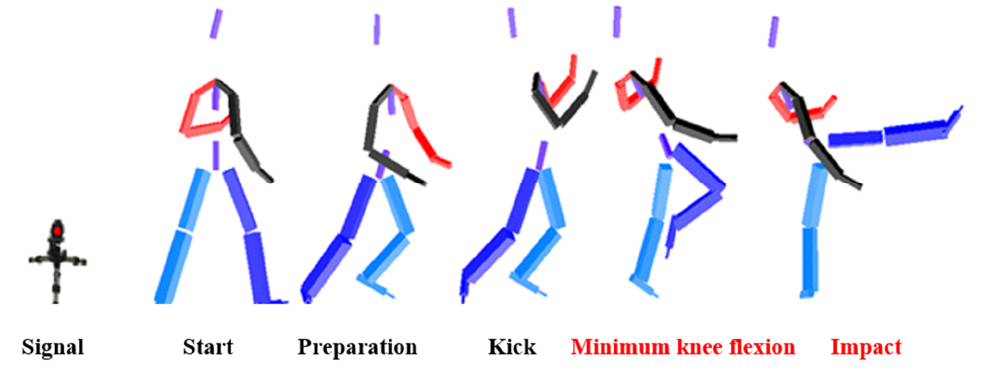
Figure 5 . The events of the roundhouse kick. Figure 5. The events of the roundhouse